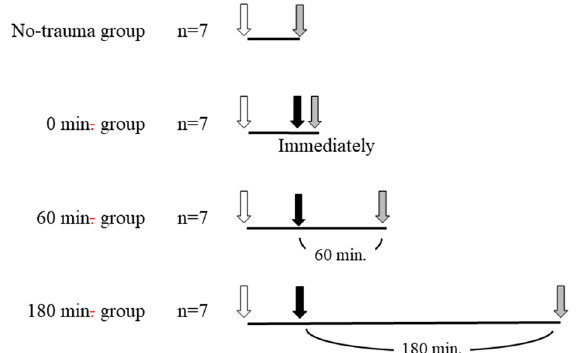
Figure 1. The schema of the experimental procedures. In no-trauma group, blood and tissue samples were collected following anesthesia. In the 0 min group, 60 min group and 180 min group, following anesthesia, severe blunt trauma was inducted. In the 0 min group, blood and tissue samples were collected immediately following induction of trauma. In the 60 min and 180 min group, blood and tissue samples were collected